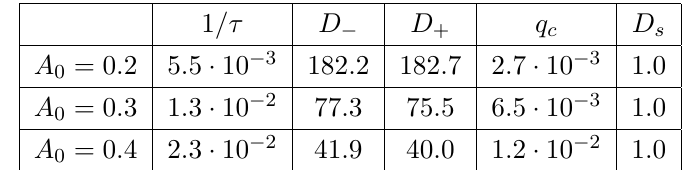
Figure 3 . Dispersion relation for the lowest modes in the presence of a lattice with A 0 = 0 : 2 ; 0 : 3 ; 0 : 4. As we increase q , two modes move towards each other on the imaginary axis, until they collide and acquire a non-vanishing real part. The third mode remains on the imaginary axis. After the collision, the curves depicting the dispersion relations become essentially featureless, so we do not display the data points for large values of q to ease readability of the (cid:12)gures.